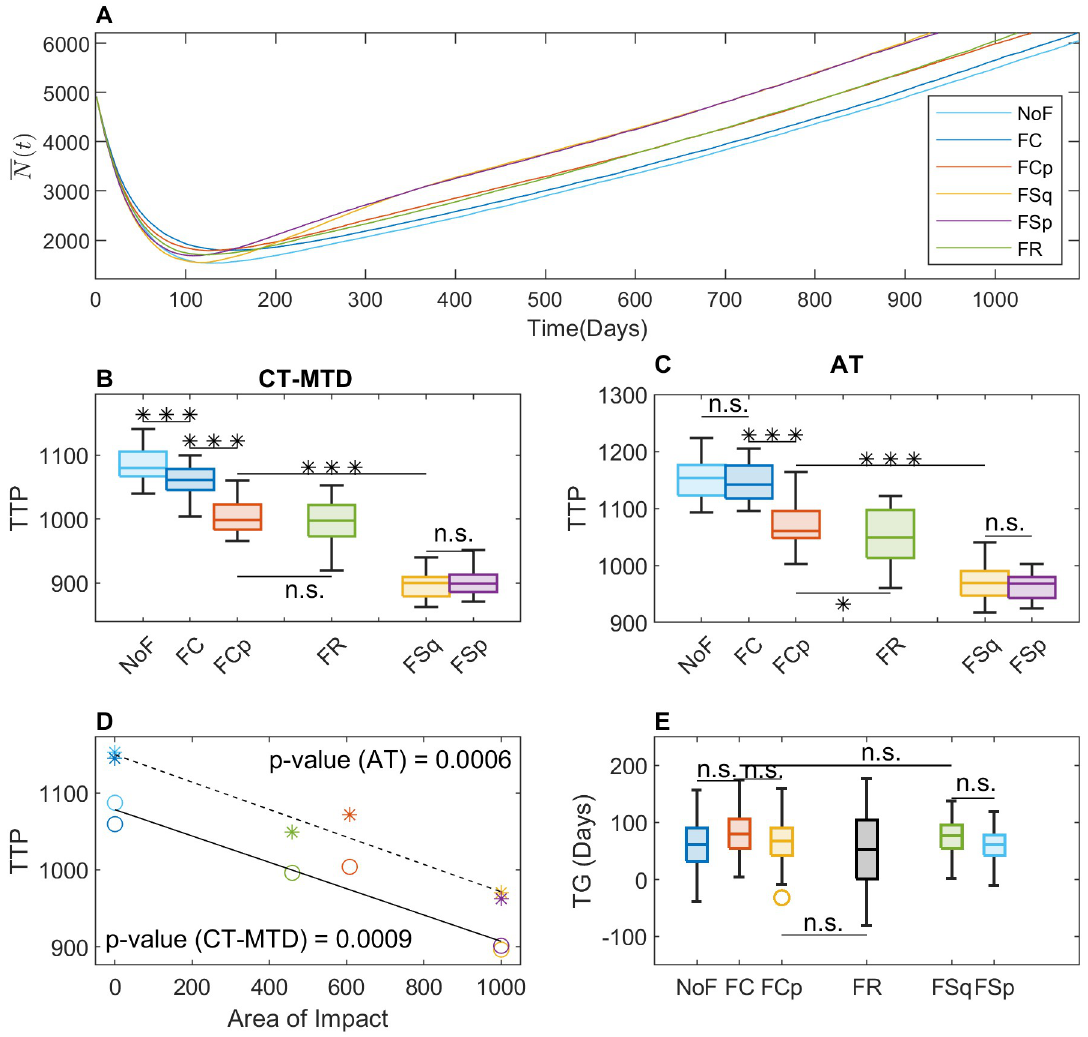
Fig 10. CAF-mediated growth with clumped initial R-cell distribution and cell migration ( α = 2, m = 1). ( A ) The time evolution of the average of the total cell population ( � N ð t Þ ) under CT-MTD in the 30 simulations is shown for all types of CAF configurations. ( B ) Boxplot of the time to progression (TTP) under CT-MTD in the 30 realizations. ( C ) Boxplot of the time to progression under AT in the 30 realizations. ( D ) Correlation of TTP with the perimeter of impact. The circles and the asterisks (the colors are similar to the legend in A) show the TTP under CT-MTD and AT respectively. solid line: CT-MTD and dashed line: AT regression line. The p − values for AT and CT-MTD indicate significance of the correlation. ( E ) Time gain (TG) is shown as boxplots for all type of CAF